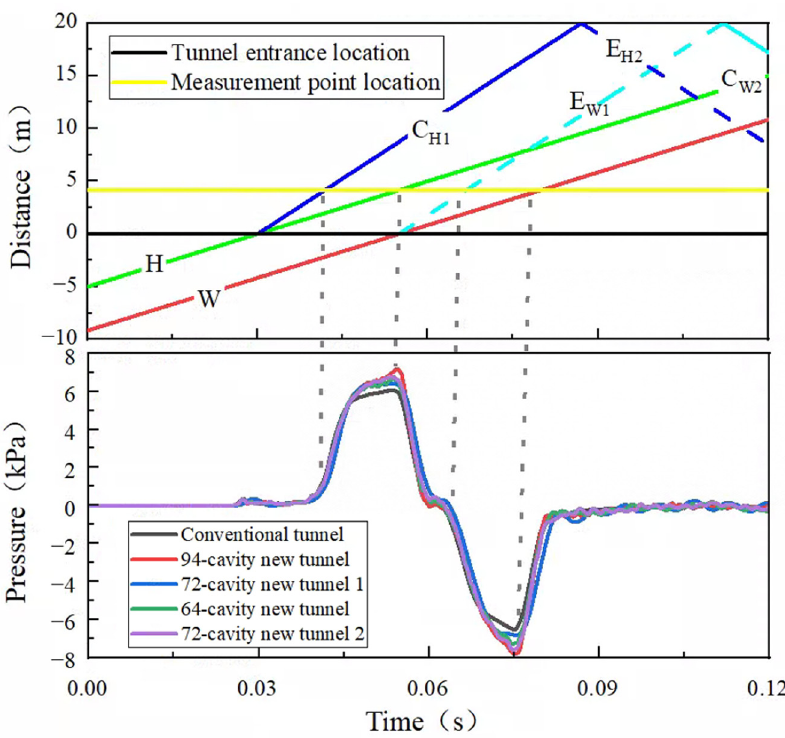
Figure 14. Comparison of wall pressures for different solutions.